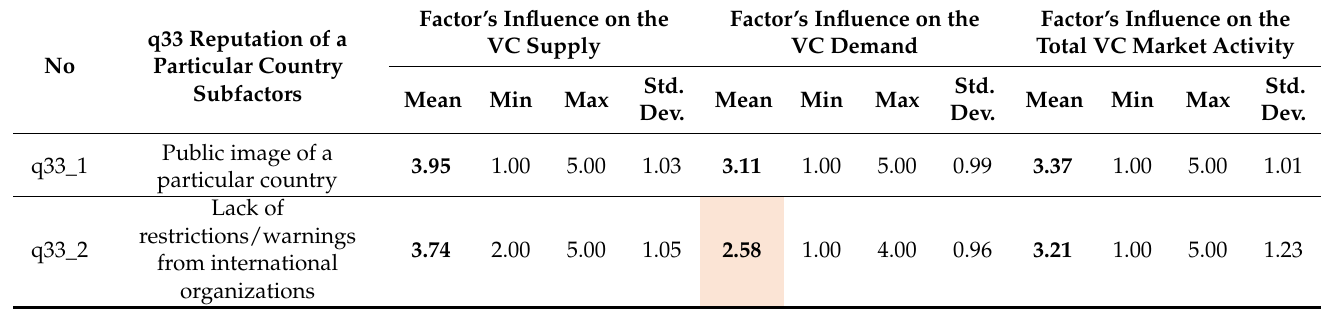
Table 19. The subfactors related to the reputation of a particular